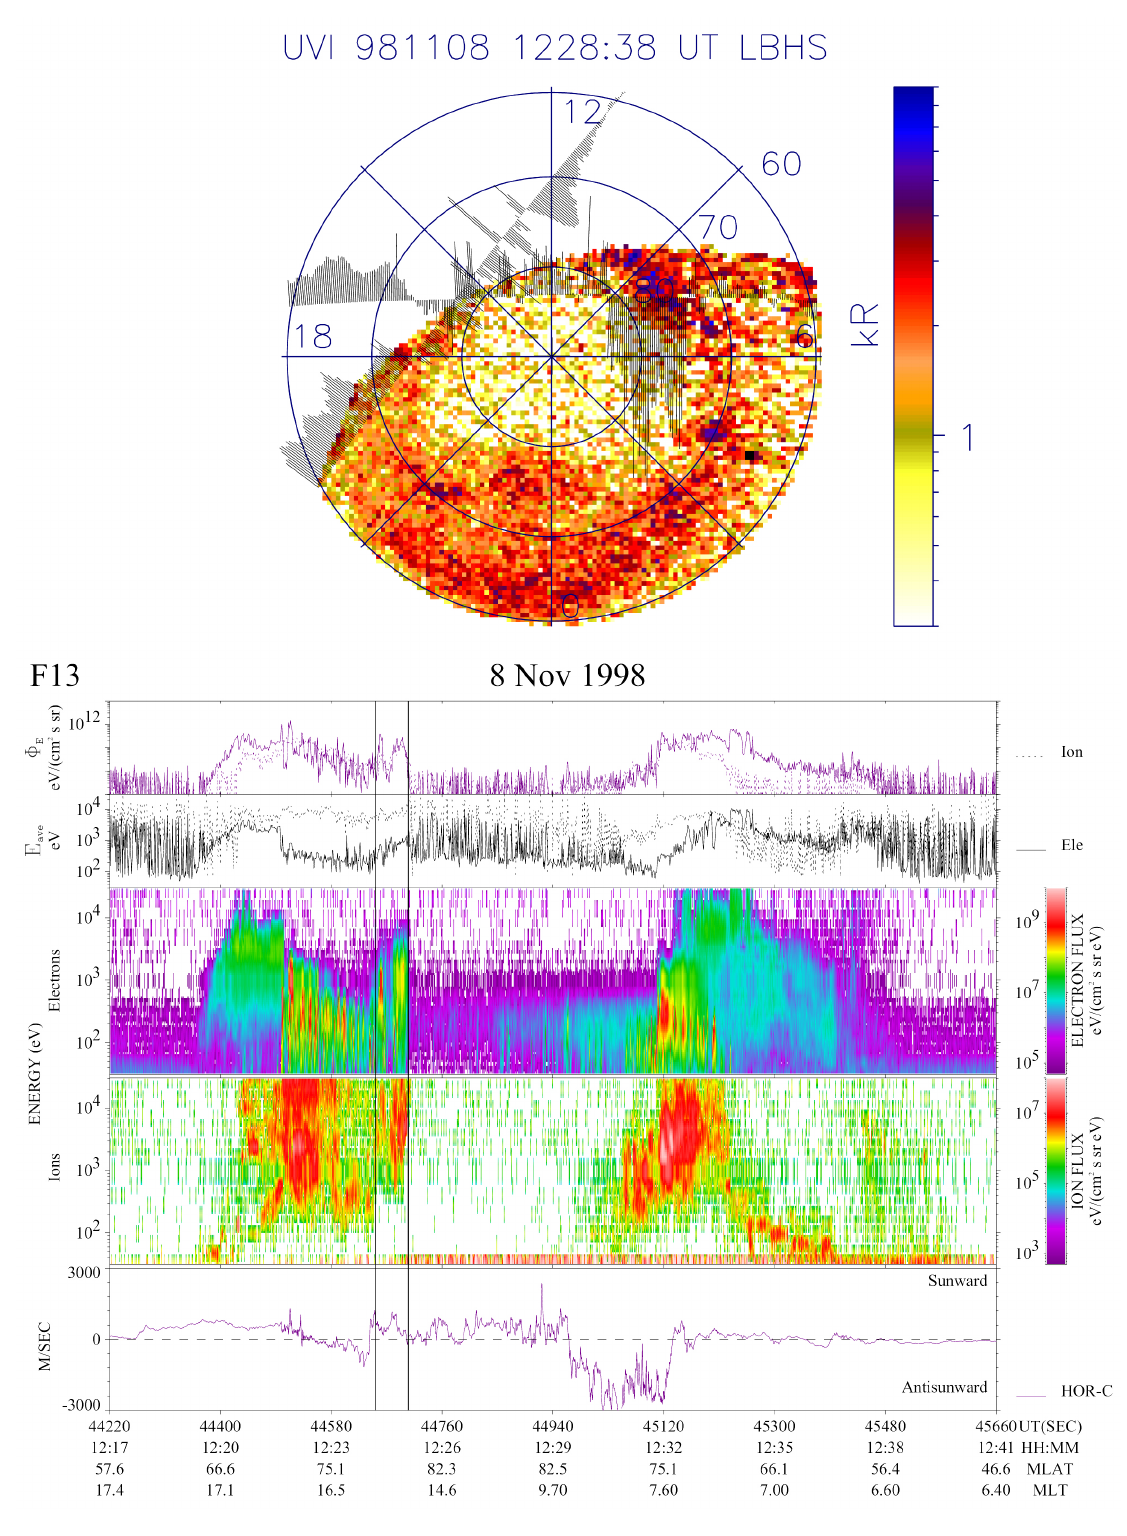
Fig. 4. Data shown from the first DMSP pass on 8 November 1998 (12:17–12:41UT) that occurs during the Polar UVI data period. At the top are the F13 and F14 horizontal plasma flows, perpendicular to the satellite track plotted over a UV image taken at the time F13 is at highest magnetic latitudes. The F13 spectrogram (lower panel) includes, from top to bottom, (1) electron and ion integral energy flux, (2) electron and ion average energy, (3) precipitating electron spectrogram, (4) precipitating ion spectrogram, and (5) cross-track horizontal plasma drift. See text for